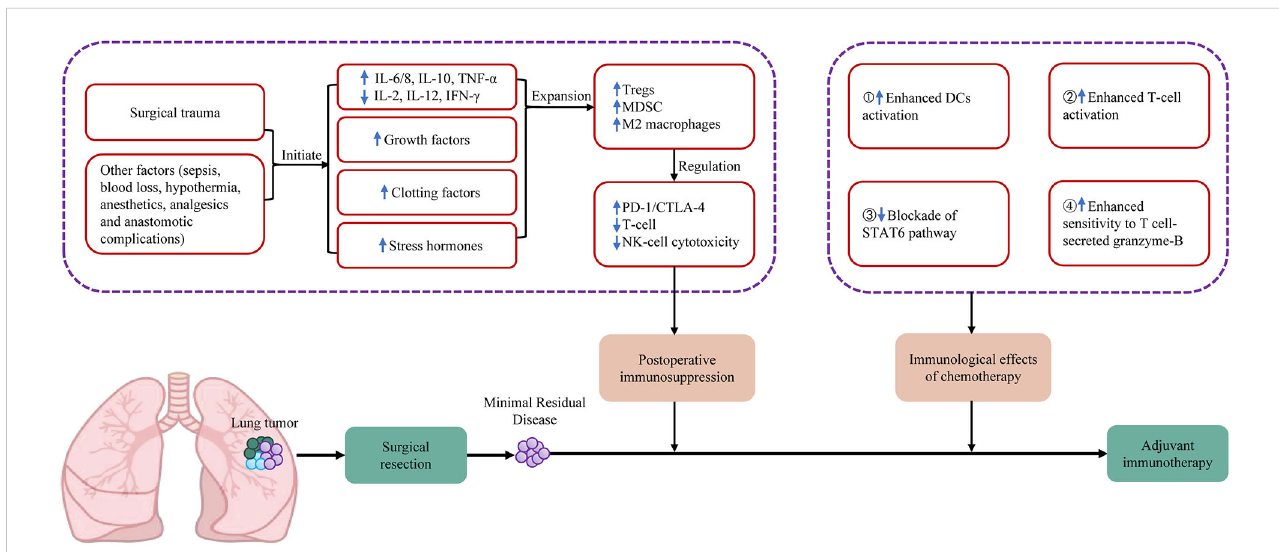
FIGURE 1 Summary of mechanisms of postoperative immunosuppression and immunological effects of chemotherapy on the tumour microenvironment. CTLA-4, cytotoxic T-lymphocyte-associated protein 4; DCs, dendritic cells; IFN, interferon; IL, interleukin; MDSC, myeloid derived suppressor cells; NK cell, natural killer cell; PD-1, programmed cell death protein 1; STAT6, signal transducer and activator of transcription 6; TNF, tumor necrosis factor; Tregs, regulatory T